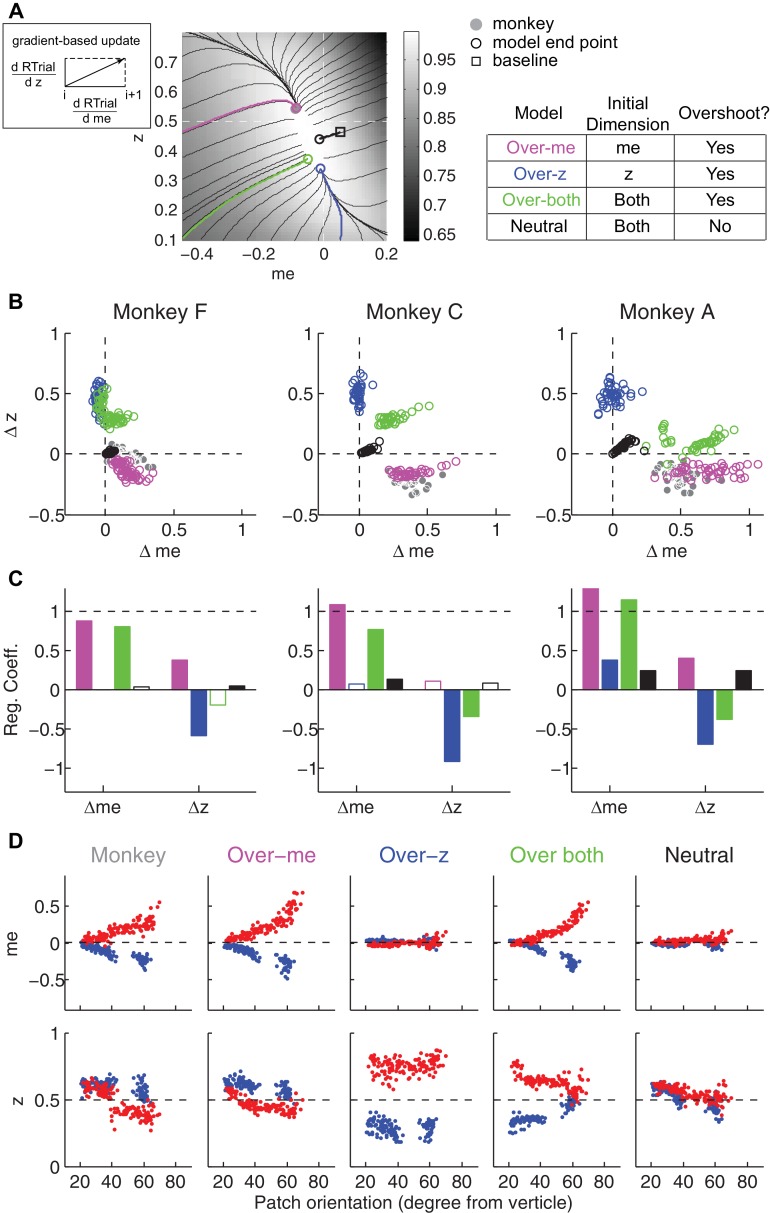
The satisficing reward function gradient-based model.(A) Illustration of the procedure for predicting a monkey’s me and z values for a given RTrial function. For better visibility, RTrial for the LR-Left reward context in an example session is shown as a heatmap in greyscale. Gradient lines are shown as black lines. The square indicates the unbiased me and z combination (average values across the two reward contexts). The four trajectories represent gradient-based searches based on four alternative assumptions of initial values (see table on the right). All four searches stopped when the reward exceeded the average reward the monkey received in that session (RTrialpredict), estimated from the corresponding best-fitting model parameters and task conditions. Open circles indicate the end values. Grey filled circle indicates the monkey’s actual me and z. Note that the end points differ among the four assumptions, with the magenta circle being the closest to the monkey’s fitted me and z of that session. (B) Scatterplots of the predicted and actual Δme and Δz between reward contexts. Grey circles here are the same as the black circles in Figure 4C. Colors indicate model identity, as in (A). (C) Average regression coefficients between each monkey’s Δme (left four bars) and Δz (right four bars) values and predicted values for each of the four models. Filled bars: t-test, p<0.05. (D) Covariation of me (top) and z (bottom) with the orientation of the >97% maximal RTrial heatmap patch for monkeys and predictions of the four models. Blue: data from LR-Left blocks, red: data from LR-Right blocks. Data in the ‘Monkey’ column are the same as in Figure 6C and D. Note that predictions of the ‘over-me’ model best matched the monkey data than the other models.